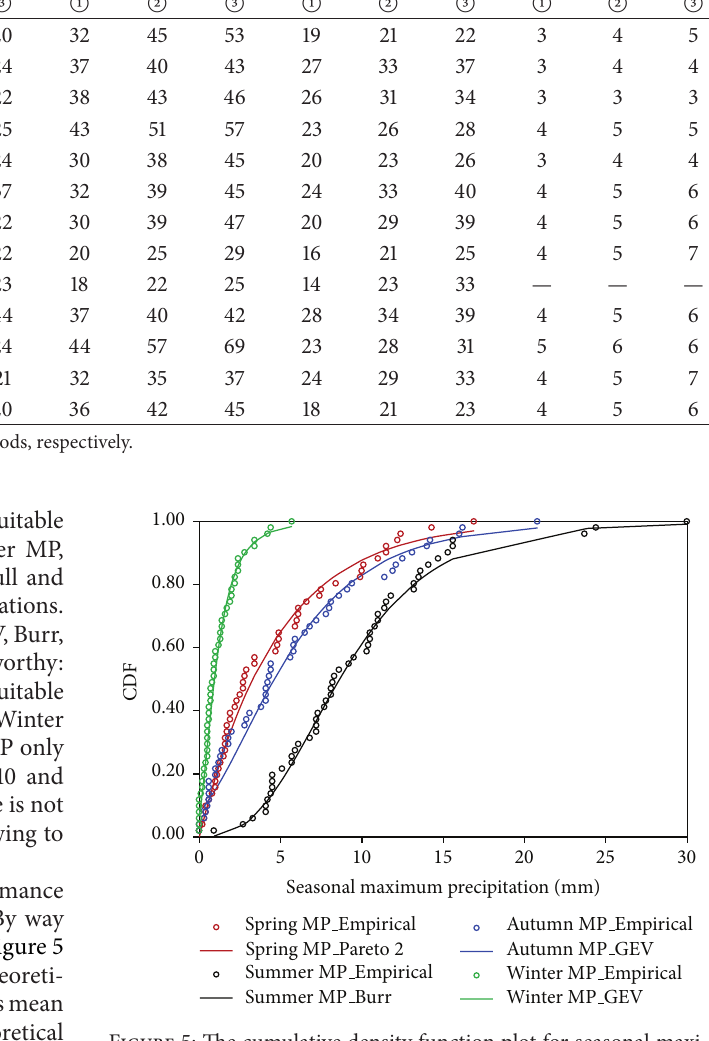
Table 4: Estimations of annual and seasonal maximum precipitation at different return periods by using the best fitted model (mm). Station ID